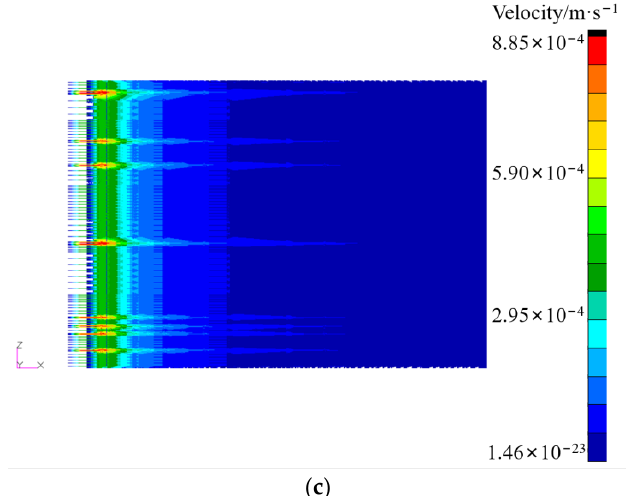
Figure 14. Velocity profiles of ( a ) the two-layer model, ( b ) the three-layer model, and ( c ) the multilayer model in the x-z section.